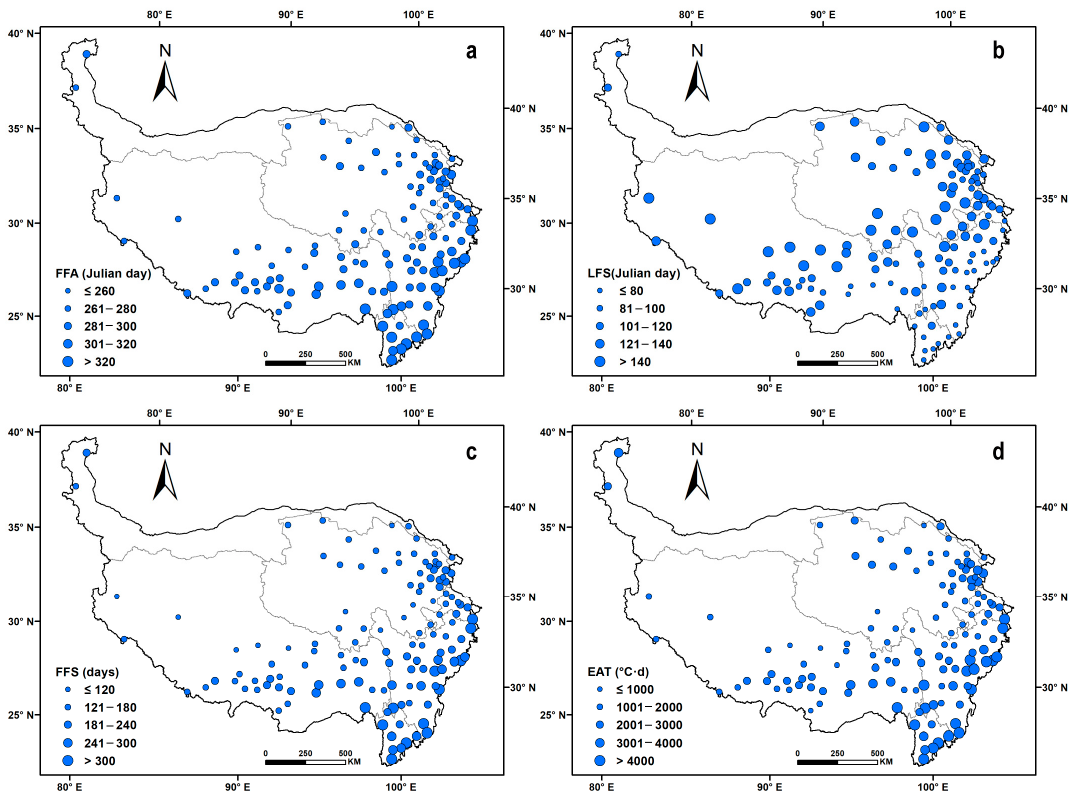
Figure 4. Annual mean values of the first and last frost days (Julian days) and frost-free periods on the Qinghai–Tibetan Plateau in the 1978–2017 period. a–d represent the spatial distribution of annual mean values of FFA, LFS, FFS and EAT at the site level.